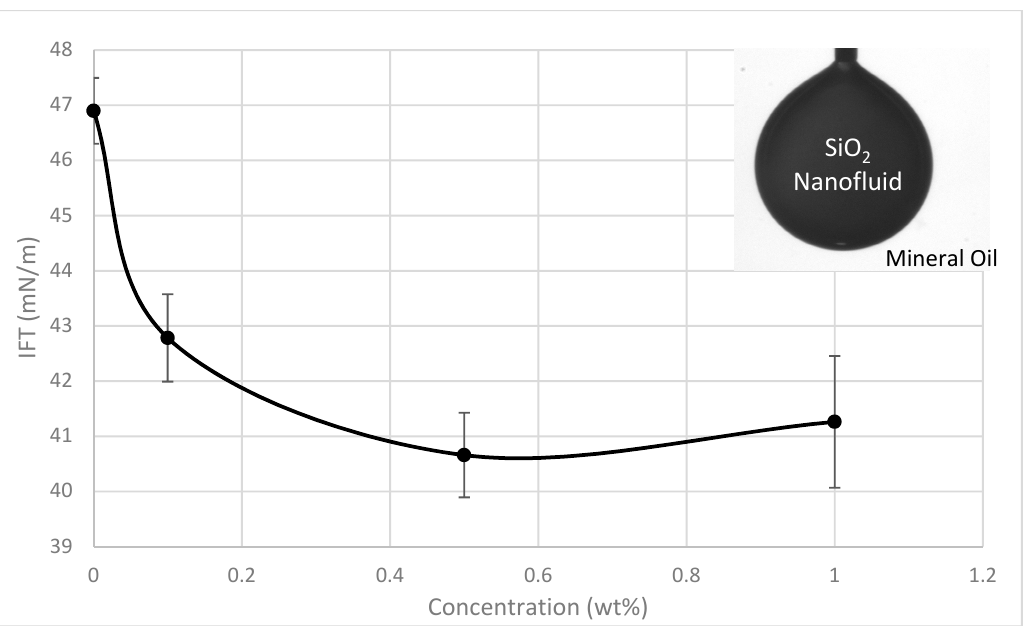
Figure 15. Interfacial tension of brine and various SiO 2 nanofluid concentrations.